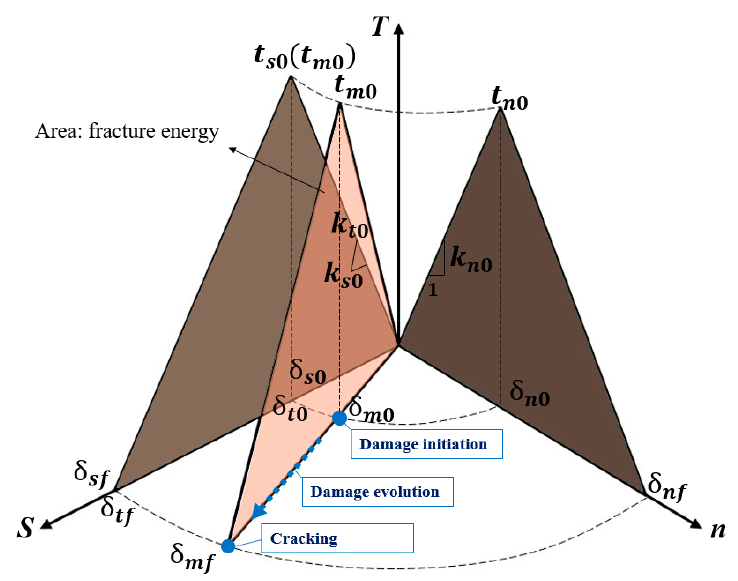
Figure 2. Traction separation response.